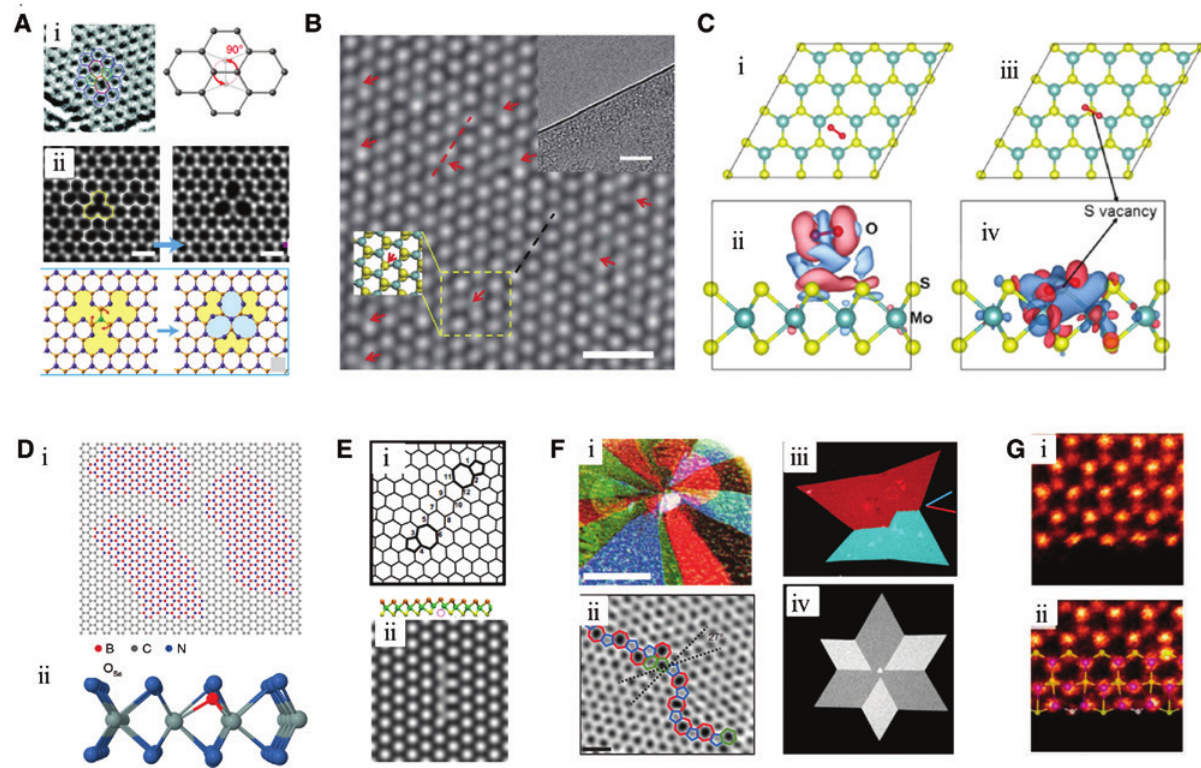
Figure 1: The types of defects in 2D materials. (A) SW defects. (i) High-resolution transmission electron microscopy (HRTEM) image of SW defects in graphene. Reprinted with permission from [51]. Copyright 2008 American Chemical Society. (ii) The filtered annular dark-field images of SW defects in WSe (top) and the atomic model of T to T transformation (bottom). Reprinted with permission from [34]. Copyright 2 0 1 2015 Nature Publishing Group. (B) Atomic structure of a monolayer MoS by aberration-correct TEM. Reprinted with permission from [21]. 2 Copyright 2013 Nature Publishing Group. The SVs are highlighted by red arrows. (C) Relaxed configuration and charge density